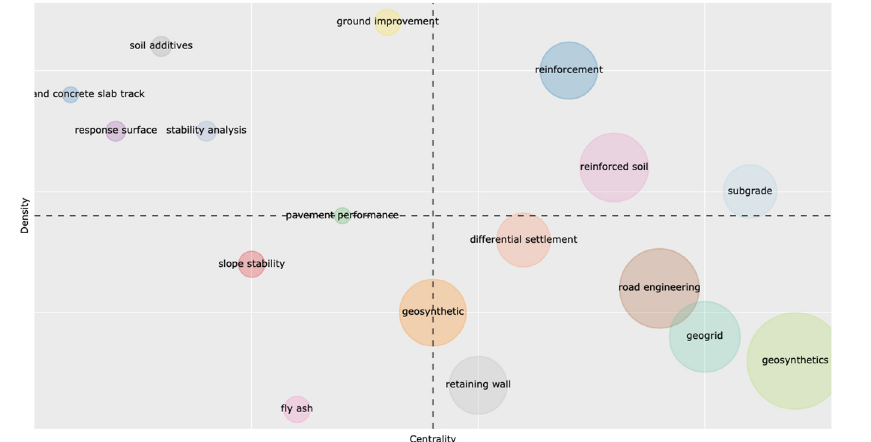
Figure 23. Thematic evolution over five periods.